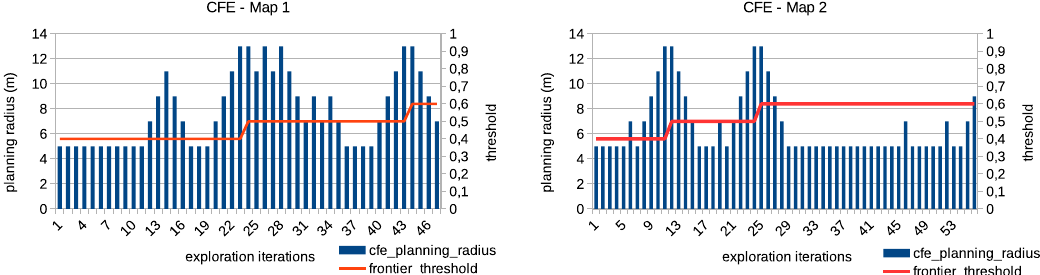
Figure 11. Adaptation of the planning radius and frontier threshold during the exploration of the maps 1 and 2 using the CFE